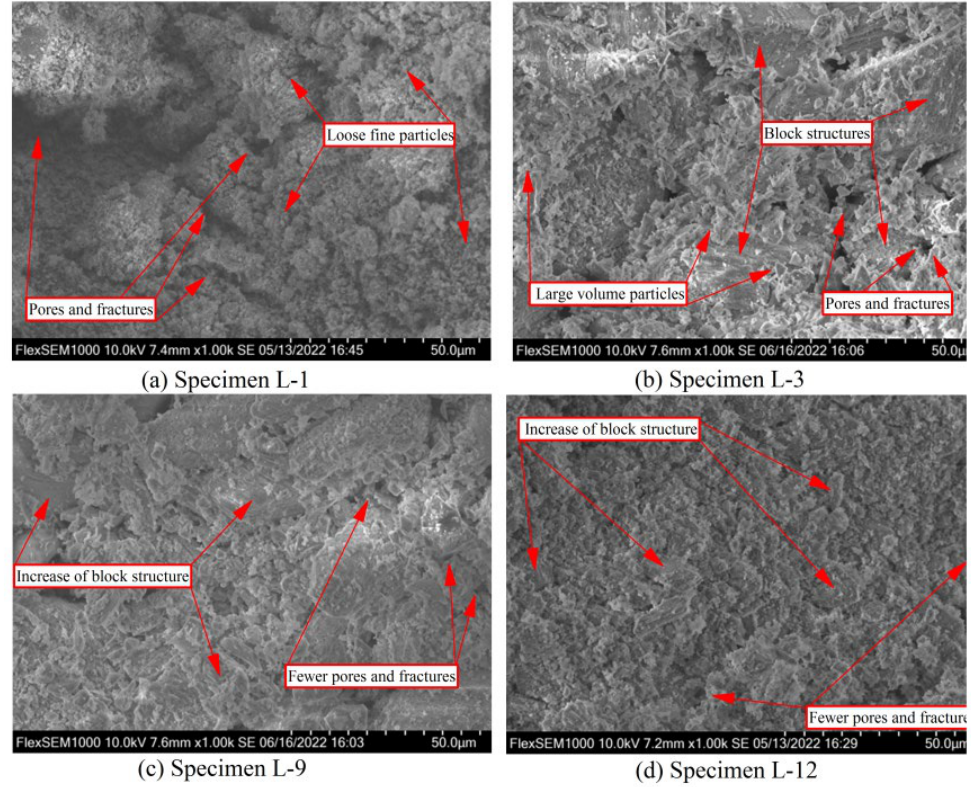
Figure 5. SEM analysis of specimens L-1 to